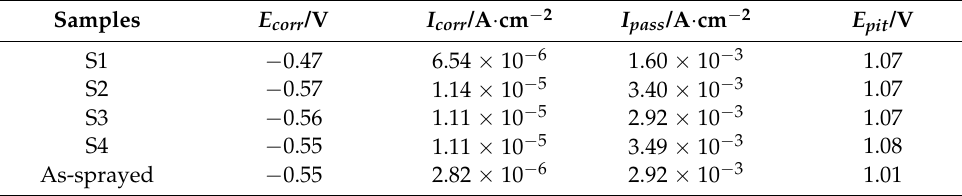
Table 3. Electrochemical measurement parameters during polarization.